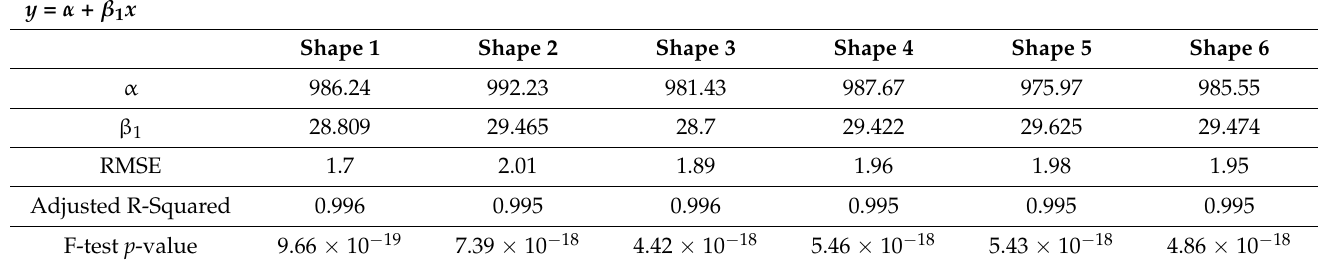
Table 11. Fitted lines of roof construction type (U-Value).